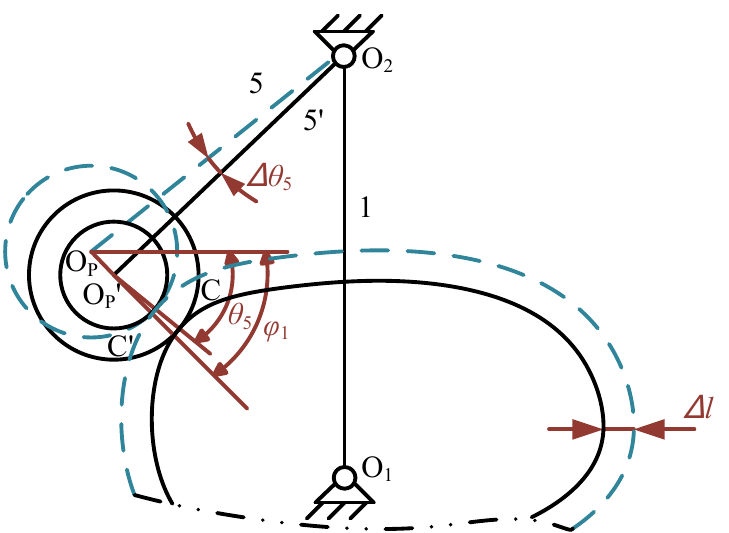
Figure 5. Error diagram of the swing cam mechanism. Figure 5 . Error diagram of the swing cam mechanism. Ideally, the cam and the roller are in tangential contact at point C. However, the point would change from C to C (cid:48) , when ∆ l and r g are taken into account. Then, the angular error ∆ θ 5 of rod 5 is calculated as: